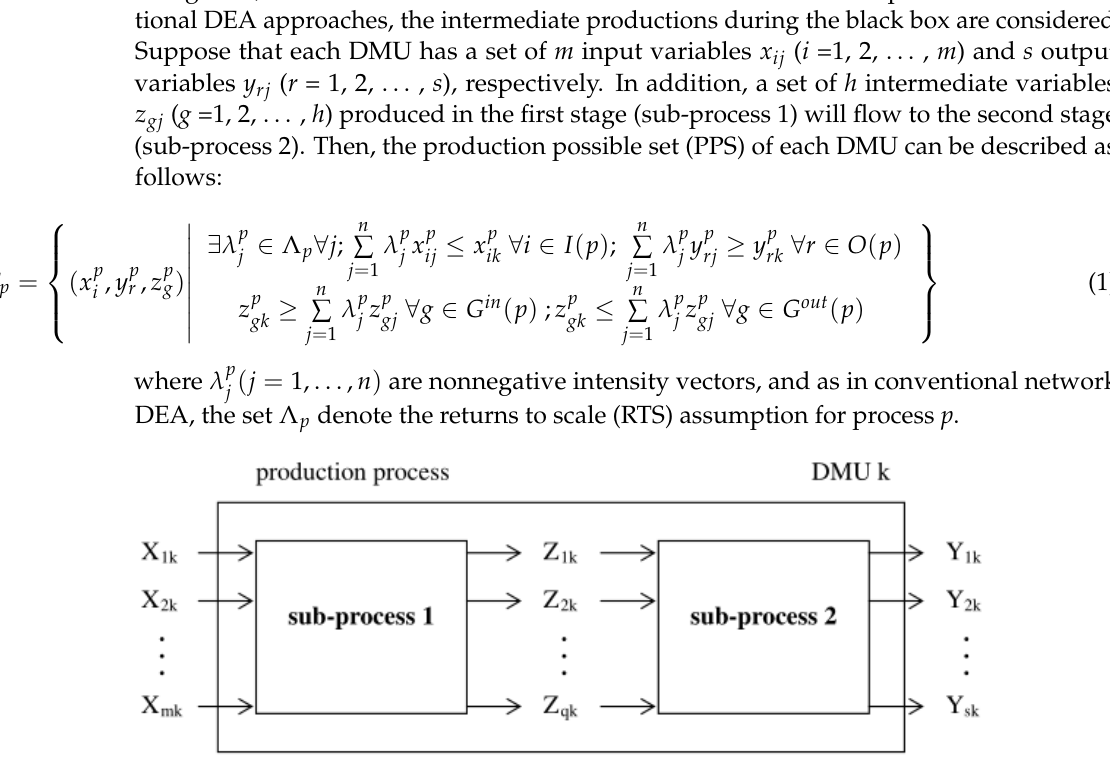
Figure 1. A two-stage network structure with intermediate products.